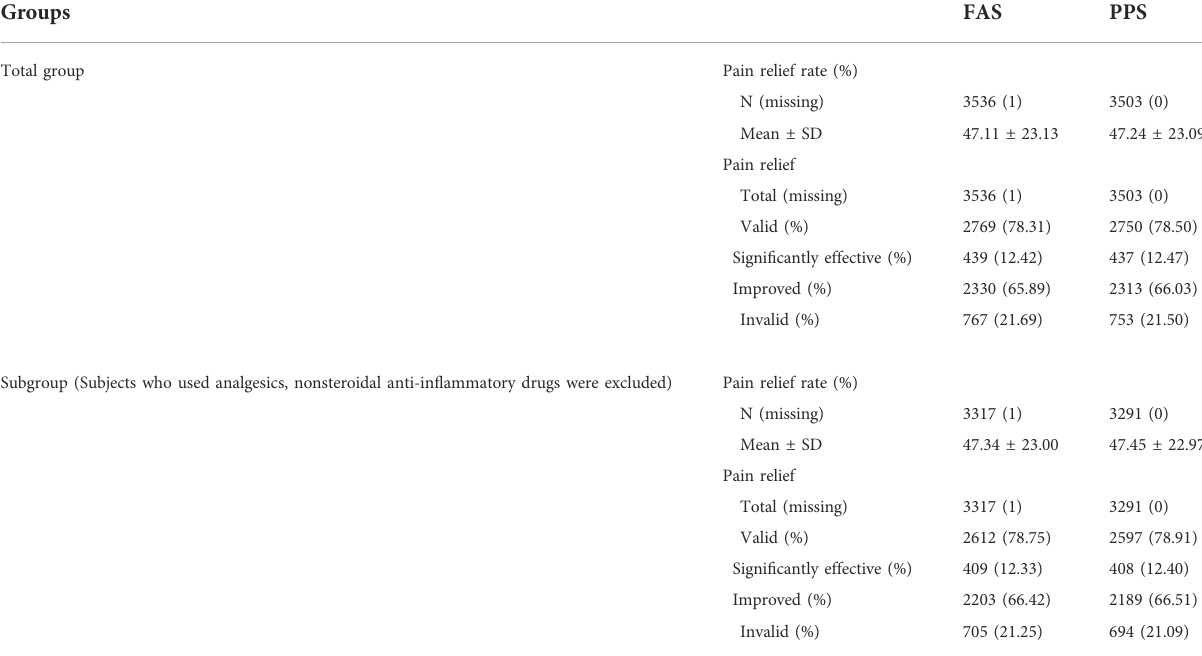
TABLE 6 Pain relief in the subjects after a course of the study drug treatment.